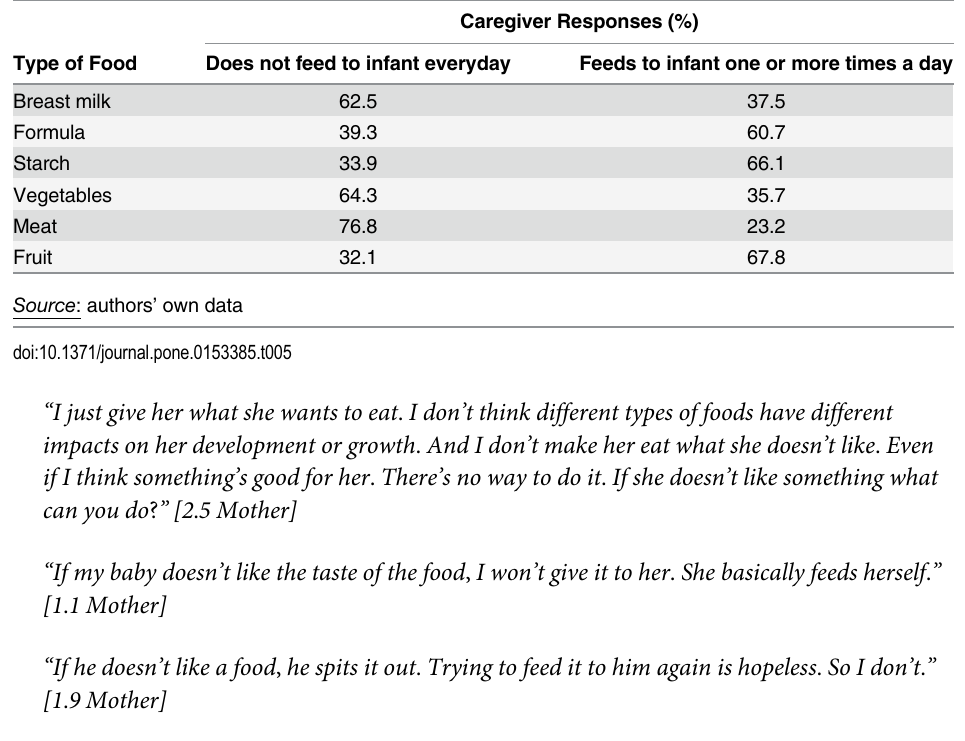
Table 5. Frequency of caregiver interview responses to feeding